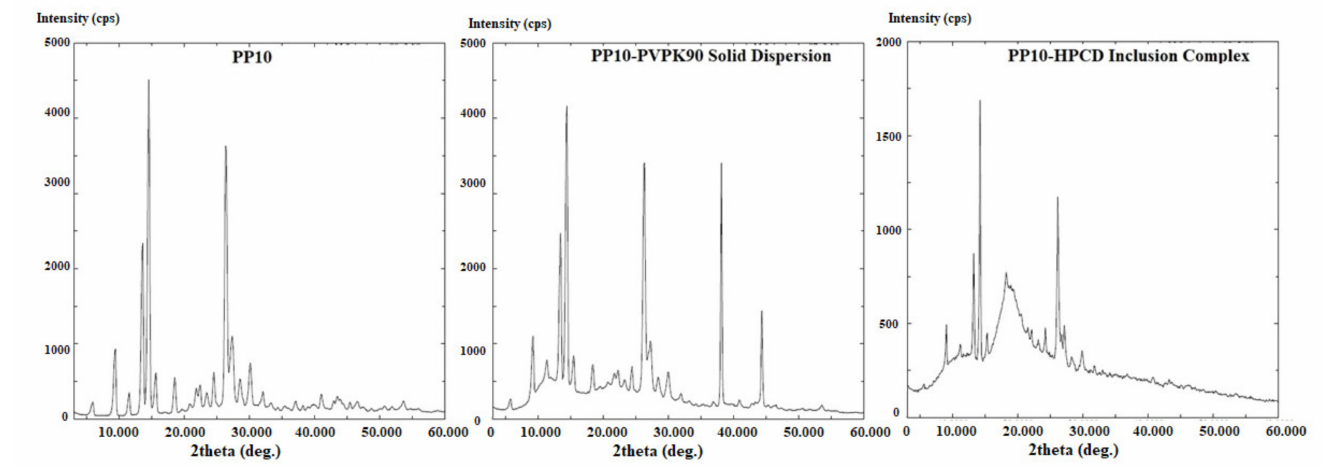
Figure 3. XRPD of PP10 and the binary systems with PVPK90 and HP- β -CD.